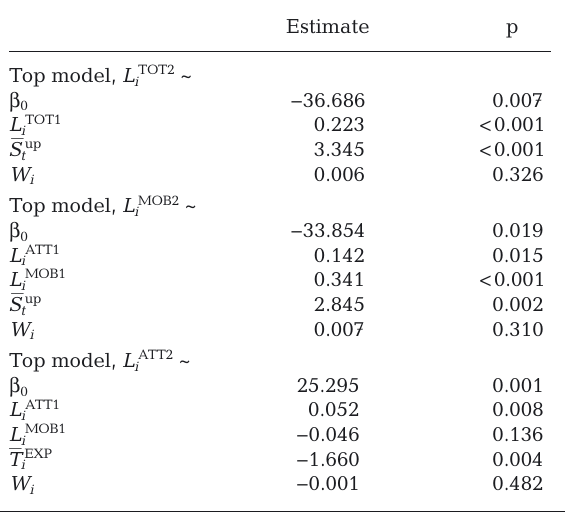
Table 4. Analysis of end-of-trial louse abundance for all stages ( L i TOT ), mobile stages ( L i MOB ), and attached stages ( L i ATT ). Top model from model selections 2a, 3, and 4a (Table S2b), where β 0 is the intercept, ⎯ T i EXP is averaged ex- perienced temperature, ⎯ S t up is averaged surface salinity (0.2 m), and W i is mean mass of start and end sample. i : variation in the factor across individuals; t : variation across time; su- perscripted 1 (start) and 2 (end) denote time of